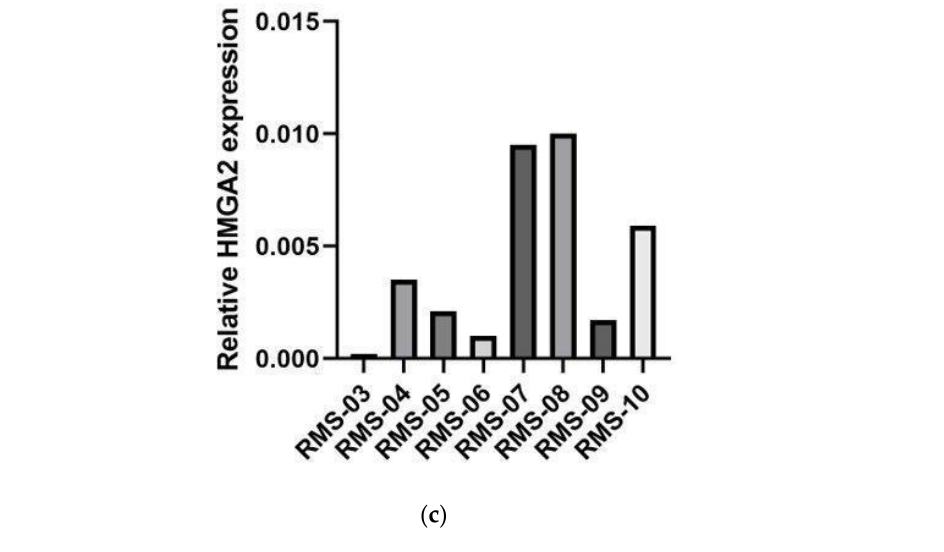
Figure 2. HMGA2, HMGB1 and HMGB2 gene expression in tumors for patients with RMS treated with BOMP/EPI. HMGB1 ( a ), HMGB2 ( b ) and HMGA2 ( c ) gene expressions in biopsies of seven patients with RMS treated with BOMP/EPI were analyzed with the EdgeSeq Oncology Biomarker Panel. The total counts of HMGA2, HMGB1 and HMGB2 obtained for each sample were normalized by GAPDH counts. RMS-03, RMS-07, RMS-08 and RMS-09: alveolar rhabdomyosarcoma tumor samples. RMS-04, RMS-05 and RMS-06: embryonal rhabdomyosarcoma tumor samples. RMS-10: spindle cell rhabdomyosarcoma tumor sample.